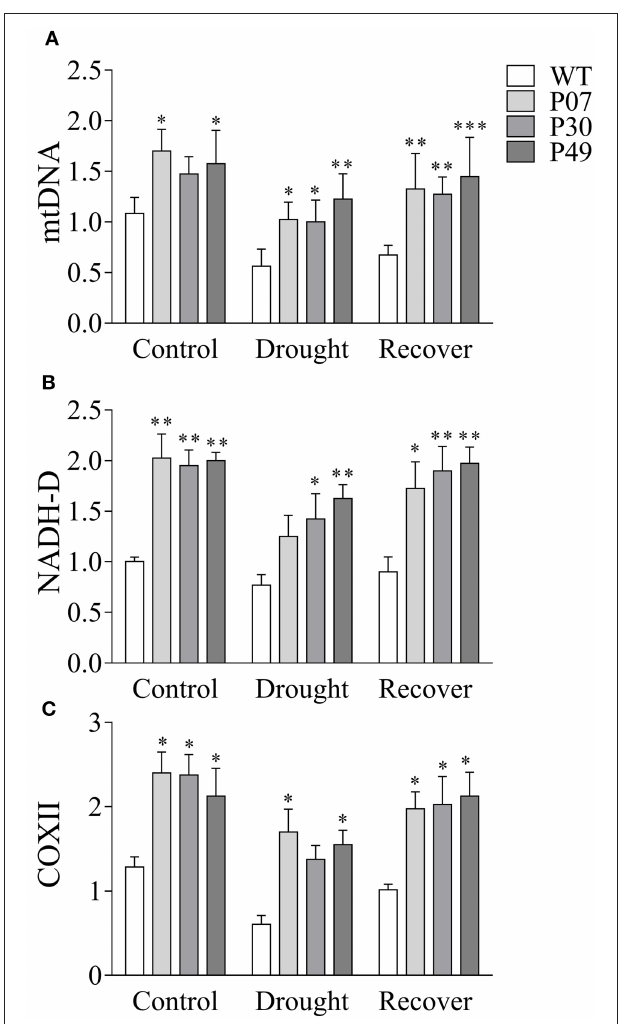
FIGURE 7 | Overexpression of AtUCP1 results in increased expression of mitochondrial transcripts in flower buds. (A) The mtDNA content is higher in transgenic lines in control, drought stress, and recovery conditions. The expressions of (B) nuclear-encoded NADH-D and (C) mtDNA-encoded COXII were also higher in transgenic plants in all conditions analyzed. Bars represent the means of 5 plants ± SD. Bars with *, **, and *** differ significantly from the WT ( P < 0.1, P < 0.05, and P < 0.01, respectively).